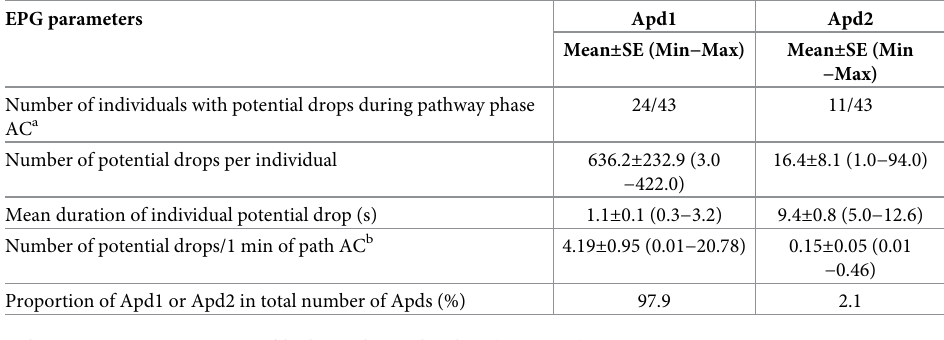
Table 3. Potential drops during AC phase stylet activities of Adelges laricis on Larix decidua . EPG